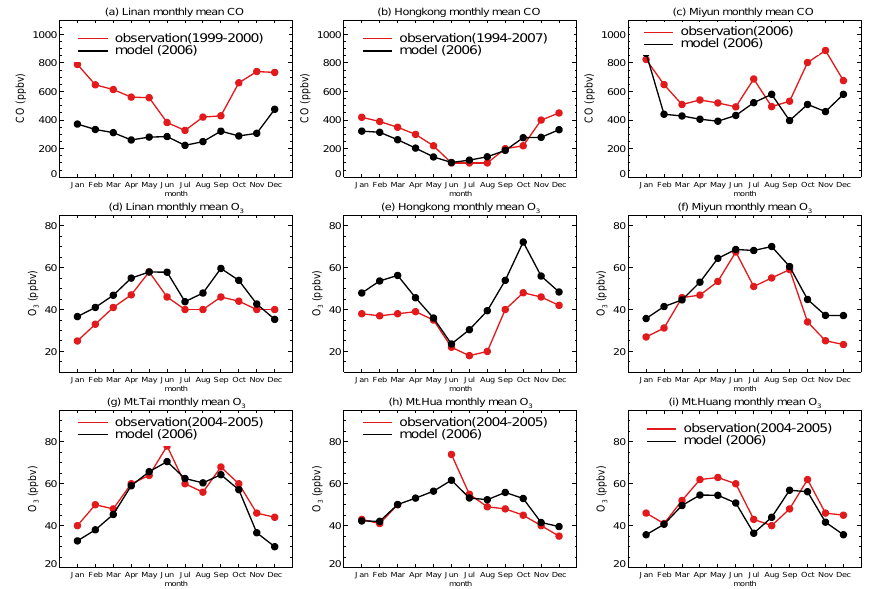
Fig. 2. Monthly mean O 3 and CO at surface and mountain sites in China. The model results for 2006 are shown in black and observations in red. The site locations are shown in Fig. 7.